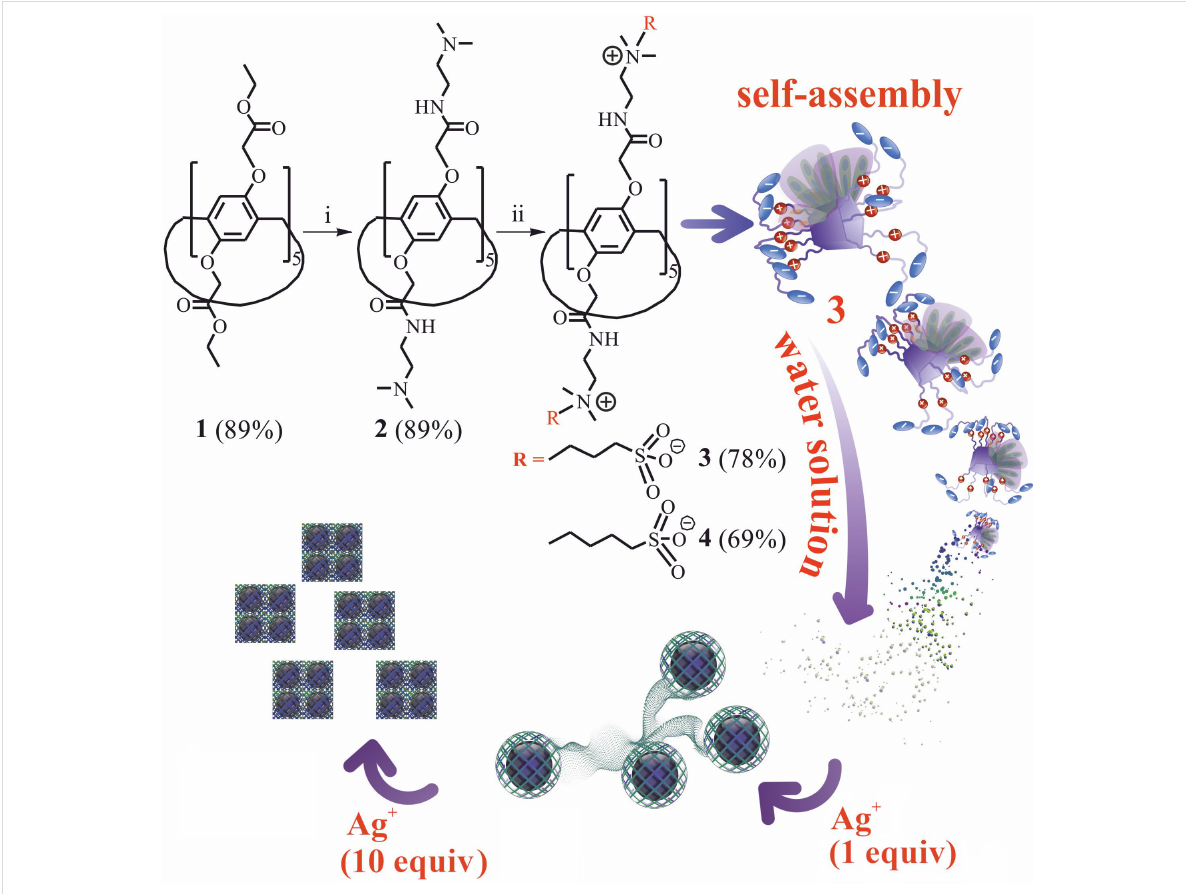
Figure 1: Synthesis of the macrocycles 3 and 4 . The sketch represents self-organization of the 3 /Ag + system depending on the amount of silver. Reagents and conditions: i – N,N -dimethylethylenediamine, MeOH, reflux; ii – 1,3-propanesultone or 1,4-butanesultone, DMF, 100 °C.